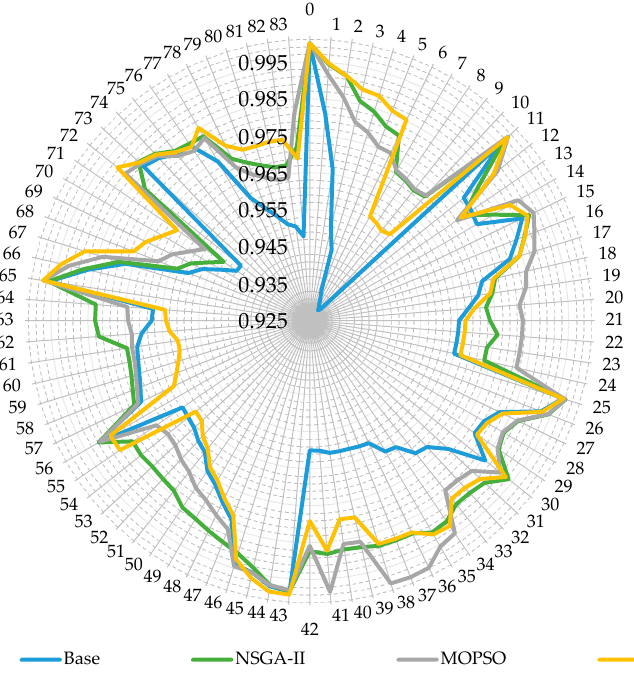
400 Table 7. DGs for 83-node distribution system.